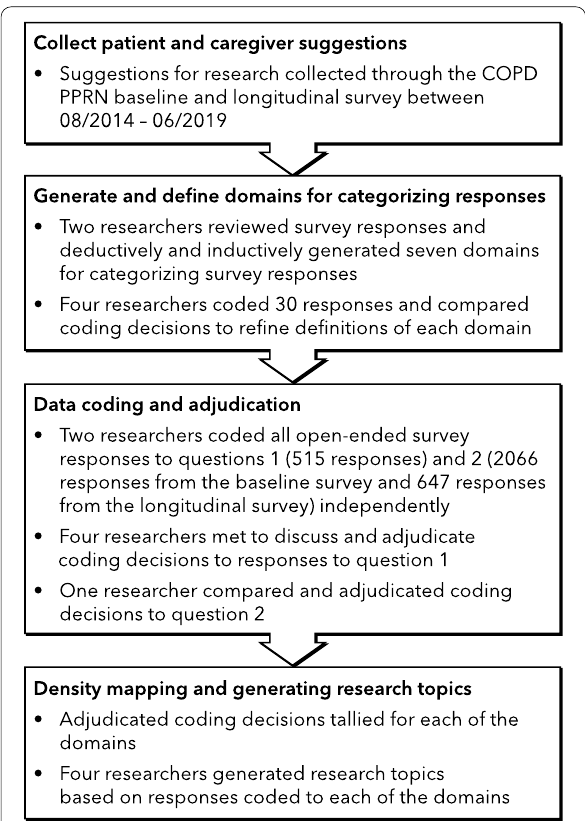
Fig. 1 Data collection and analysis